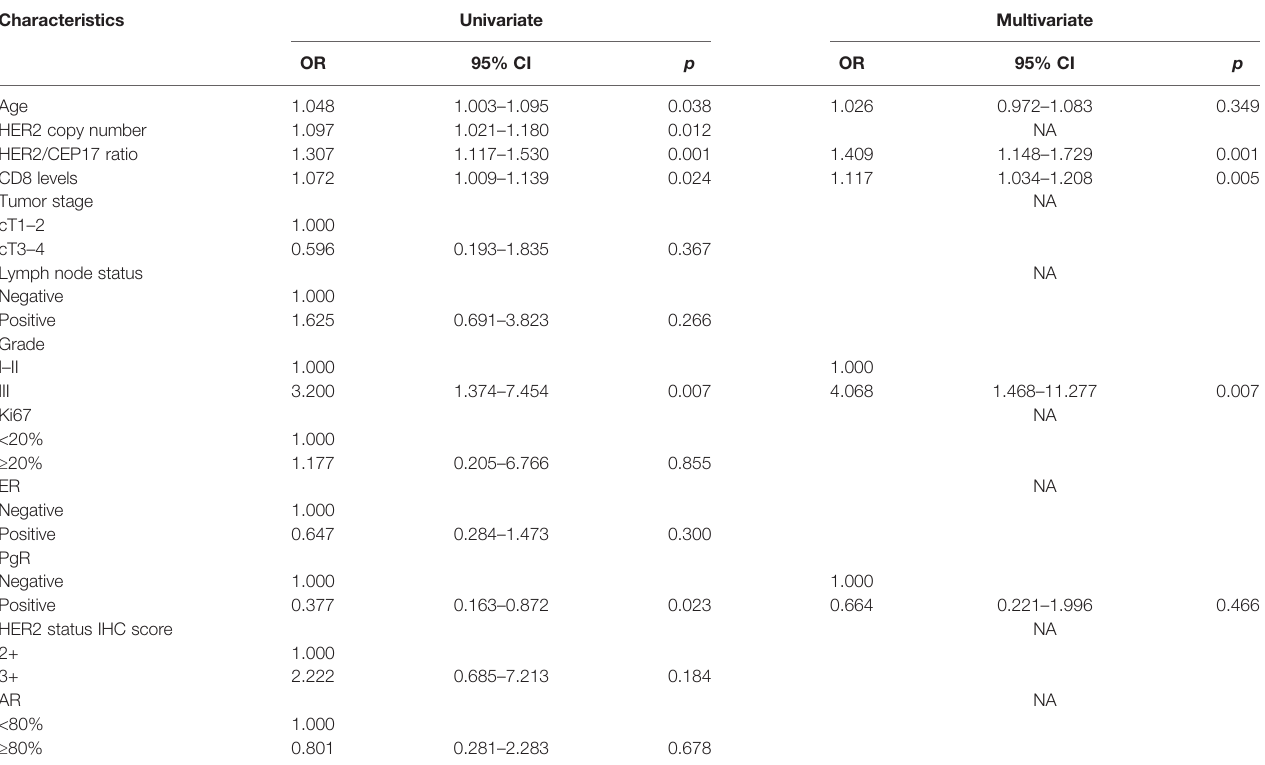
TABLE 2 | Univariate and multivariate logistic regression models predicting pathological complete response after neoadjuvant treatment in training set.